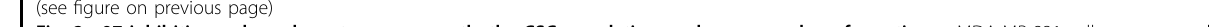
Fig. 2 p97 inhibition reduces breast cancer growth, the CSC population, and mammosphere formation. a MDA-MB-231 cells were treated with 1.25, 2.5, 5, and 10 μ M Eer I and NMS-873 for 24 h. DMSO was used as a vehicle control. The ubiquitinated proteins in cell lysates were analyzed by immunoblotting. GAPDH was used as a loading control. b Proliferation of MCF-7 and MDA-MB-231 cells treated with Eer I and NMS-873, with IC50 values indicated. c MCF10A, MCF-7, and MDA-MB-231 cells were treated with 1.25, 2.5, 5, and 10 μ M Eer I for 24 h and cell viability was measured. d Growth of orthotopic tumors formed by MDA-MB-231 cells and treated with p97 inhibitors or DMSO. e Growth of orthotopic tumors formed by ALDH + CSCs and ALDH − non-CSC cells and treated with p97 inhibitors or DMSO. f , g qPCR and immunoblotting analysis of p97, OCT4, and SOX2 in adherent and spheroid MDA-MB-231 cells. β -actin serves as a loading control for immunoblotting. h Twenty-four hours after MDA-MB-231 cells were seeded, Eer I and NMS-873 were added to the culture at 0.1, 0.4, 1.6, and 6.4 μ M for 7 days to assess their impact on mammosphere formation. DMSO was used as a vehicle control. Left: representative images of the spheres treated with 6.4 μ M Eer I or 6.4 μ M NMS-873. Bar: 100 μ m. Right: the percentage of spheres formed under each condition relative to the control group, with IC50 values indicated. i Eer I and NMS-873 were added to the culture at 0.1, 0.25, 0.5, and 1 μ M for 7 days after the secondary spheres were formed to assess their impact on mammosphere maintenance. Left: representative images of the spheres treated with 1 μ M Eer I or 1 μ M NMS-873. Bar: 100 μ m. Right: the percentage of spheres formed under each condition relative to the control group, with IC50 values indicated. Data were shown as mean + or ± SD. * P < 0.05, ** P < 0.01, and *** P <